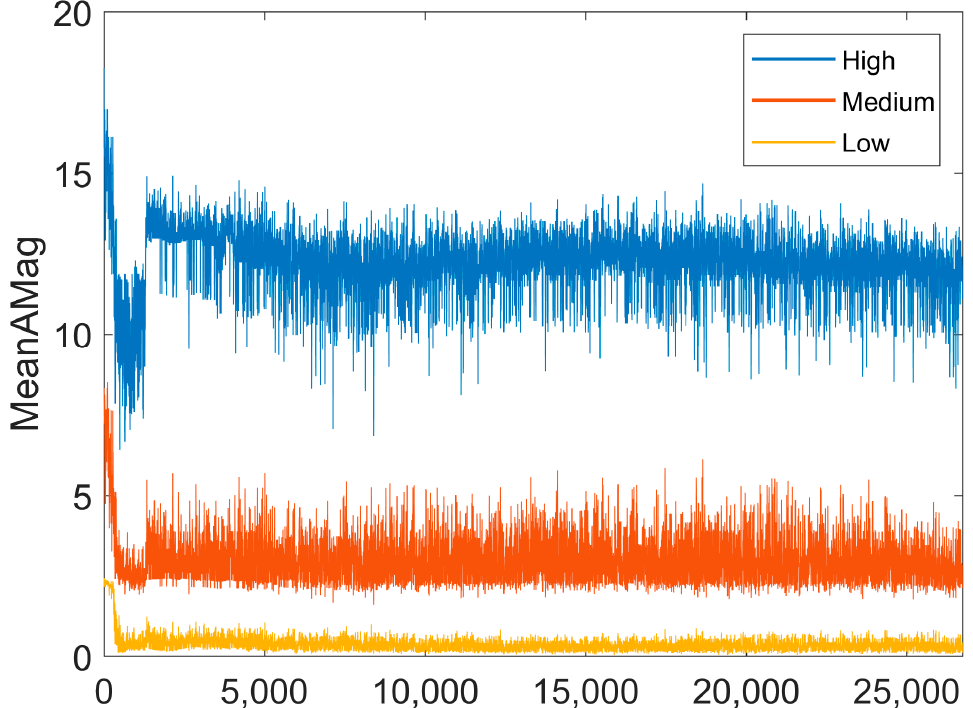
Figure 9. Evolution of the centres of the different classes computed using the k-means online learning algorithm with data collected for this study. The k-means online learning algorithm will discriminate between high, medium and low MeanAMag values.